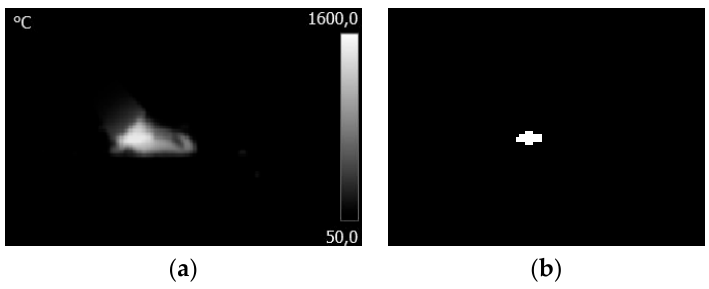
Figure 5. Processing steps of IR CAM images: ( a ) original image; ( b ) binarized and cropped image.